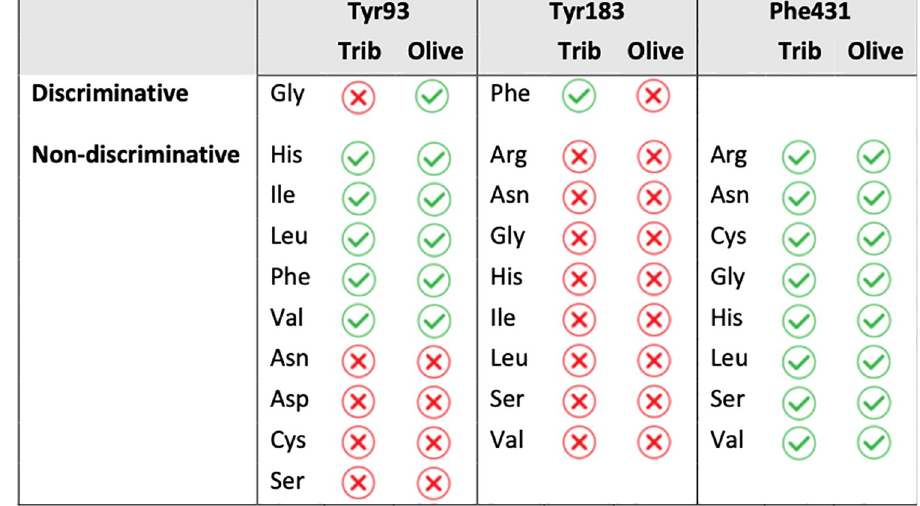
Fig 2. Short- vs long-chain hydrolytic activity in point substituted libraries of Tyr93, Tyr183 and Phe431. Variants were screened for halo formation around colonies spotted on solid medium. Hydrolysis of the short-chain tributyrin (Trib) or long-chain olive oil (Olive) were rated as active (green checkmark) or inactive (red ‘ Χ ’).